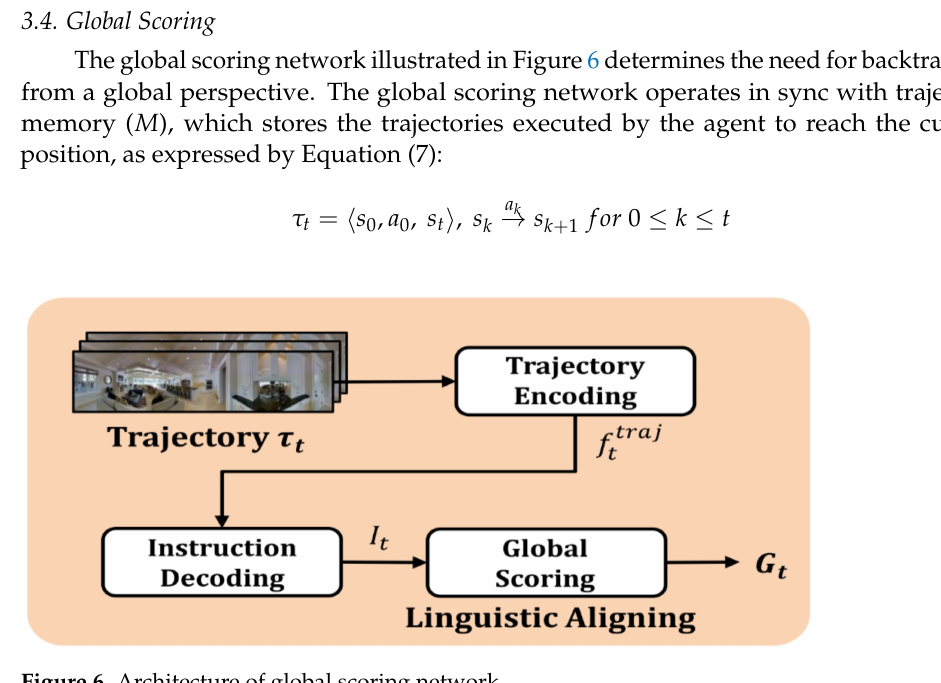
Figure 6. Architecture of global scoring